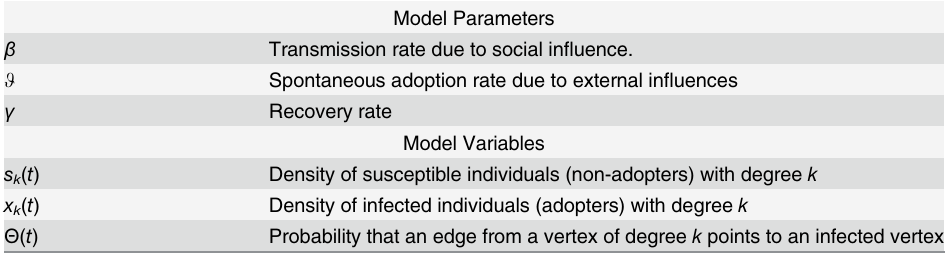
Table 1. Parameters and Variables of the